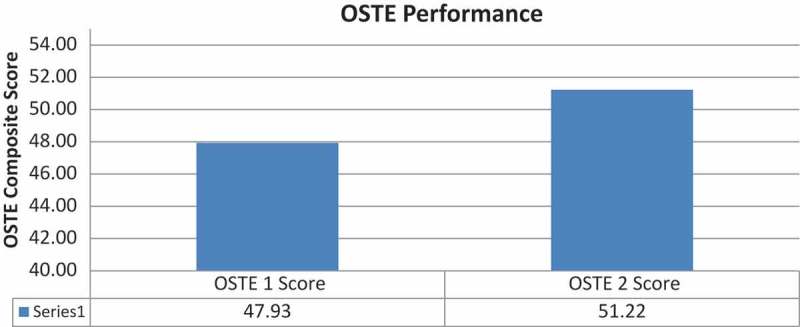
OSTE performance.